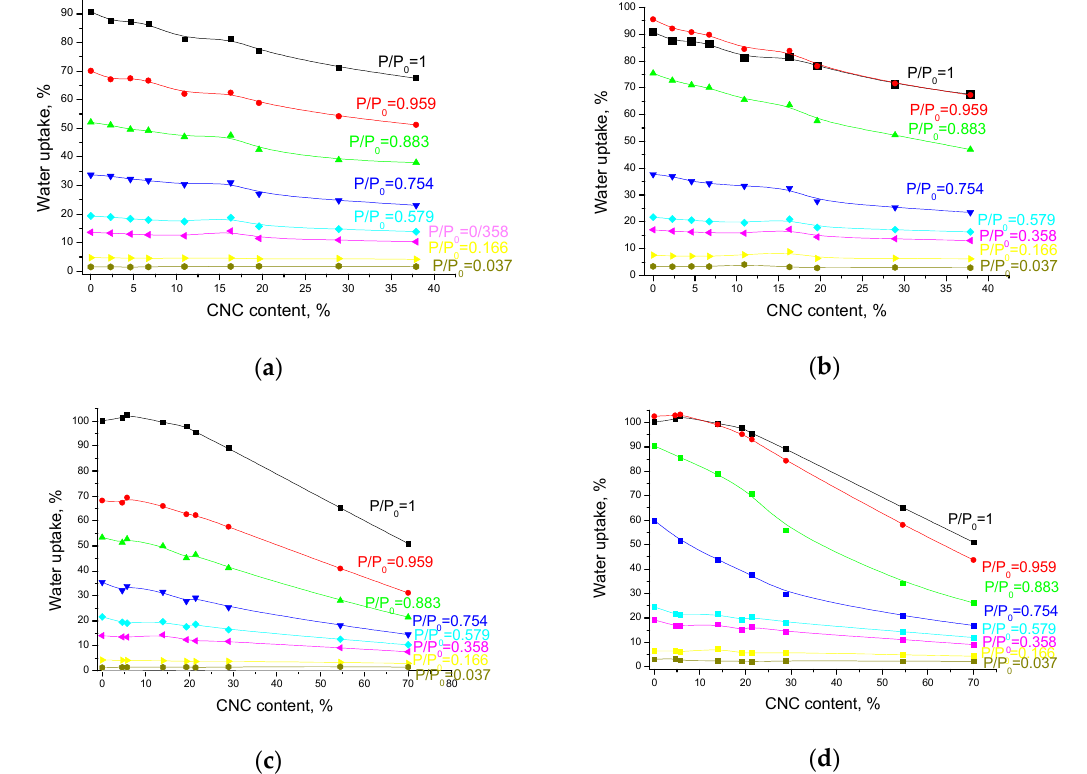
Figure 3. Equilibrium water content in the composite films ( a , b ) and aerogels ( c , d ) at water adsorption ( a , c ) and desorption ( b , d ) depending on the CNC content (P/P 0 is a relative pressure of water vapor).